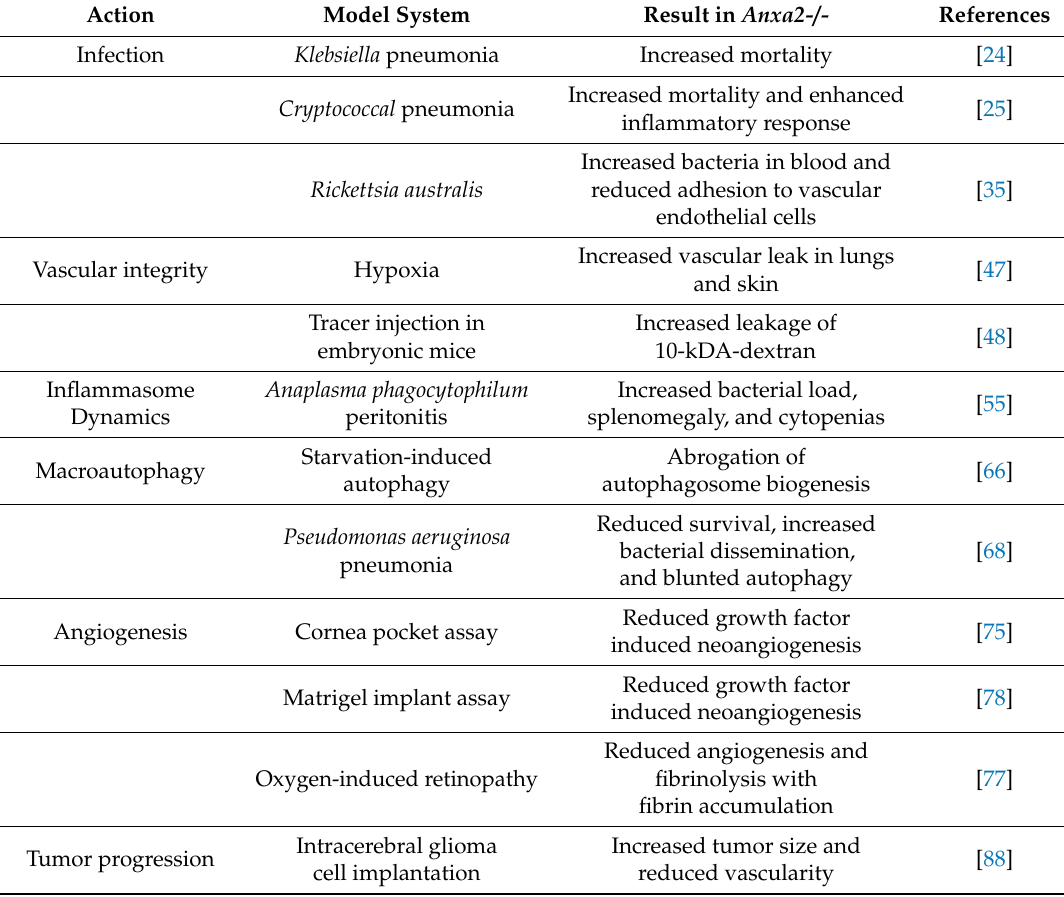
Table 2. Studies in Anxa2- / - mice revealing a role of annexin A2 in